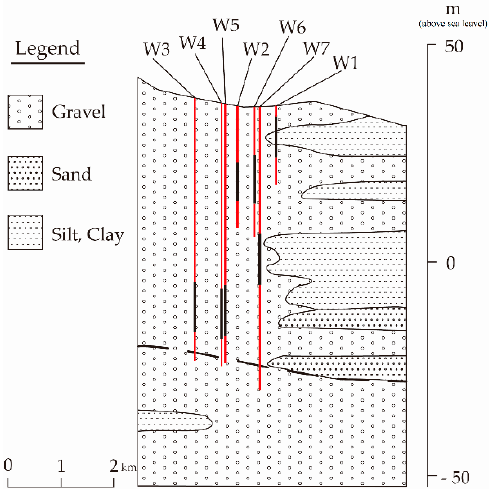
Figure 2. Location map of the study area (W1 to W7 is Well 1 to Well 7, respectively).